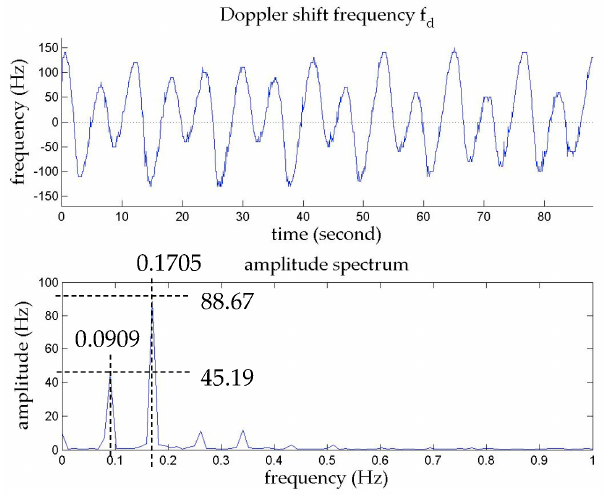
Figure 20. Extracted Doppler shift frequency and its amplitude spectrum. The harmonics of the wave frequency exist.